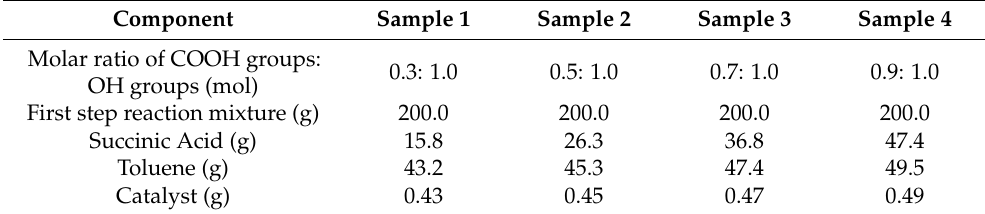
Table 1. Quantities of reagents in the second step of mixed ester